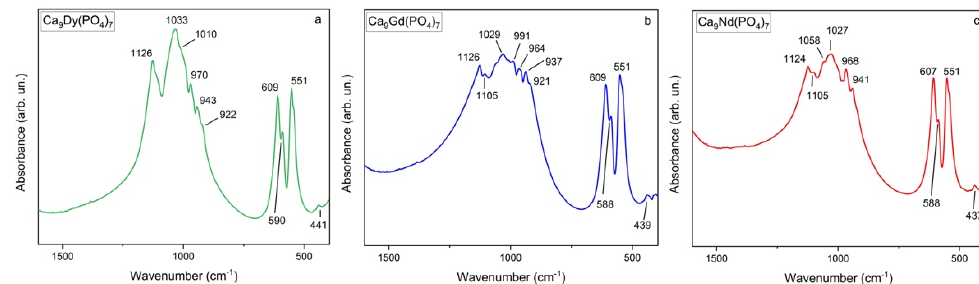
8 of 15 Figure 6. View down c of the RE β –TCP framework. Inset ( a ): (P1O 4 ) group environment and joining mechanisms with M1-M2-M3 polyhedra from adjacent B arrays. 3.2. FTIR Spectroscopy The infrared features of the studied compounds in the 1600–400 cm − 1 region (Figure 7) are consistent with the ones observed for pure β -TCP [6]. The phosphate ion has four vibrational modes active in the infrared, compatible with a C 1 symmetry: the symmetric stretching ν 1 , the symmetric double degenerate bending mode ν 2 , and the triple degener- ate asymmetric stretching ( ν 3 ) and asymmetric bending ( ν 4 ) modes [6]. The substitution of RE in Ca sites in the studied compounds only causes an increase in multiplicity, accom- panied by a shift in some of the band positions dependent of the ionic radius of the RE [6,31]. The most intense ν 3 peak is, for example, slightly shifted to lower wavenumbers